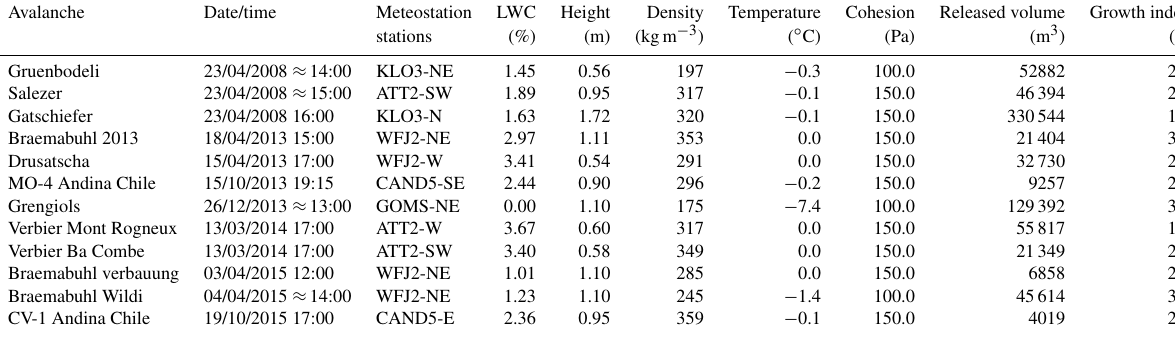
Table 2. Initial conditions derived from SNOWPACK simulations at the release for each avalanche. Avalanche